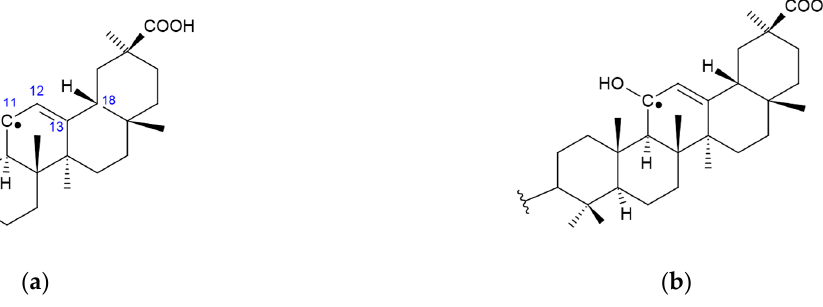
Table 2. DFT calculation of HFI constants for two paramagnetic forms of GL. Position